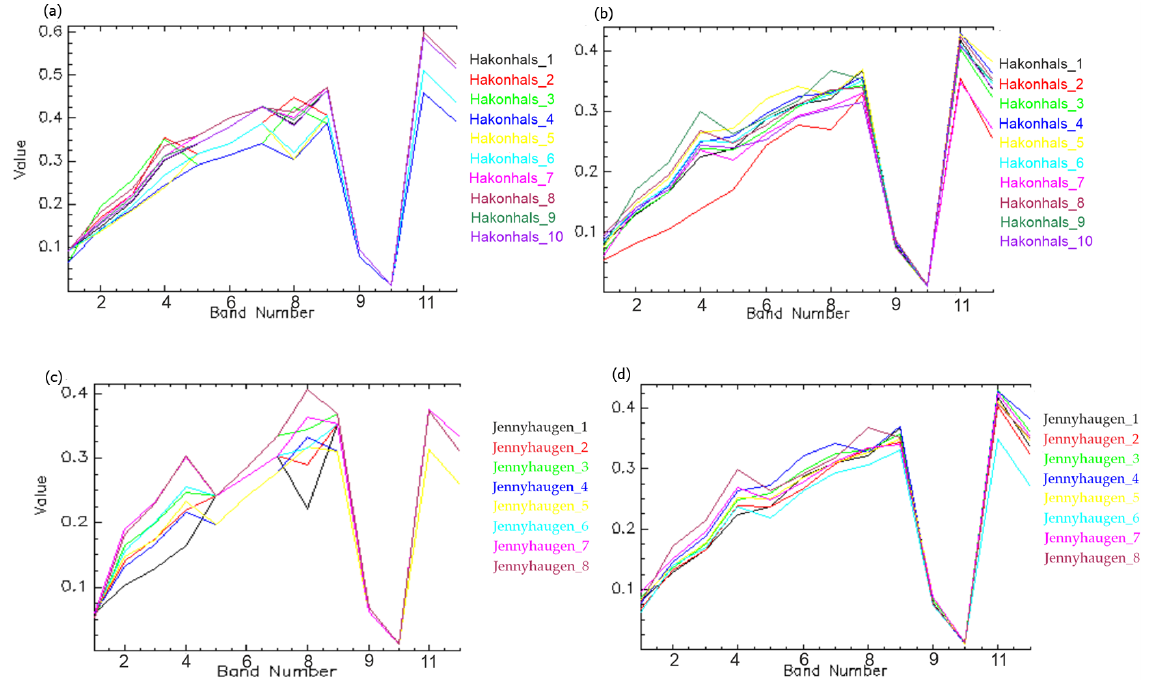
Figure 8. Sentinel 2 spectral behaviour pure pegmatite spectra (unaveraged) and mining spectra derived from averaging. Håkonhals and Jennyhaugen mines. ( a ) Håkonhals pure spectra. ( b ) Håkonhals mining spectra. ( c ) Jennyhaugen pure spectra. ( d ) Jennyhaugen mining spectra. Analysing the relationship between the reflectance of the pegmatites and the spectral range that each Sentinel 2 band covers in the continuum spectrum (Figure 9), it is possible to see that the main absorption bands are 3, 5, 8, and 12, while the most relevant bands in reflectance peaks are 4, 6, 7, and 8A.